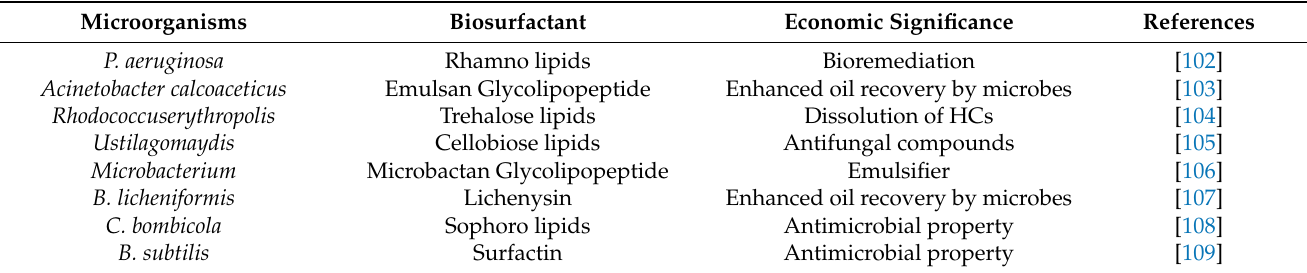
Table 4. Economic and prevalent biosurfactants in the bioremediation